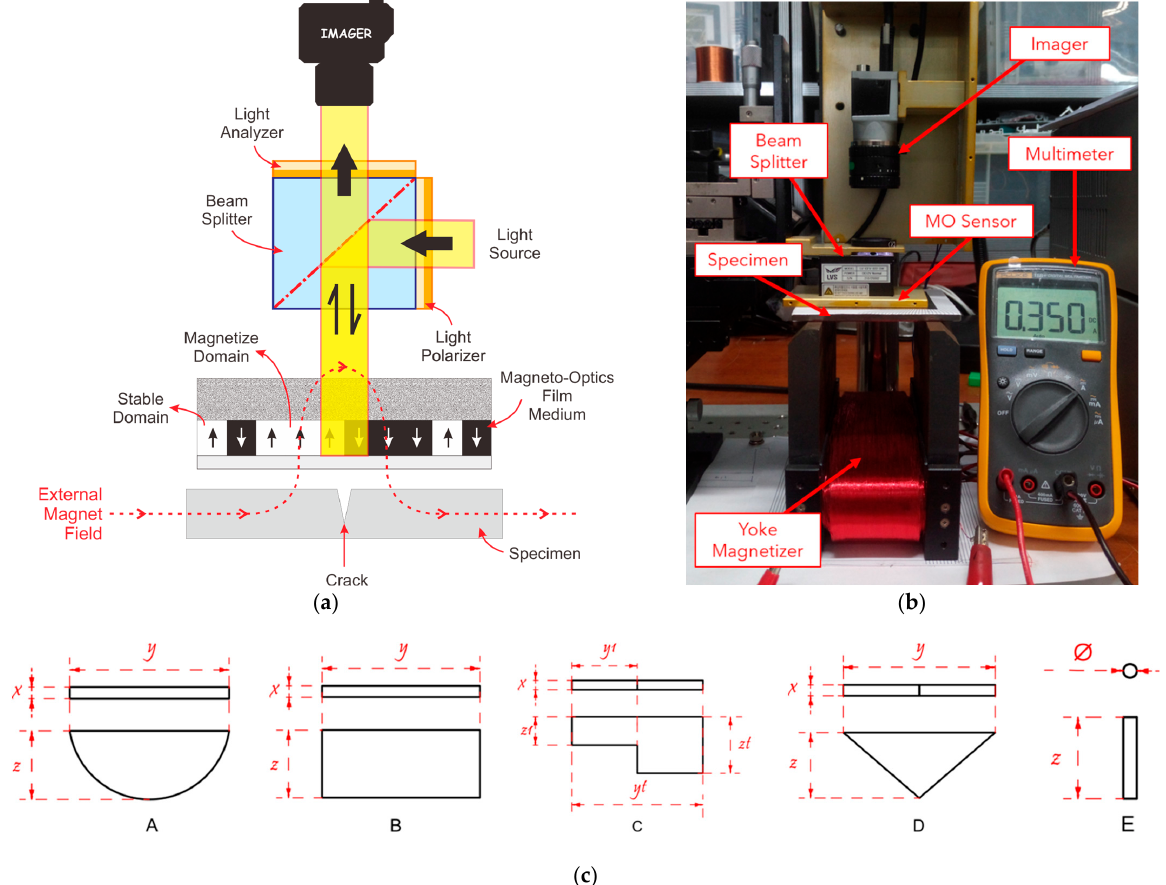
Figure 3. Data acquisition process by capturing 4752 images from 11 specimens in 72 different directions of magnetizer and six current variations using MONDI system. ( a ) Visualization of MONDI system; ( b ) experimental setup; ( c ) geometry of the defect: A (semioval), B (rectangular), C (combination), D (triangle), and E